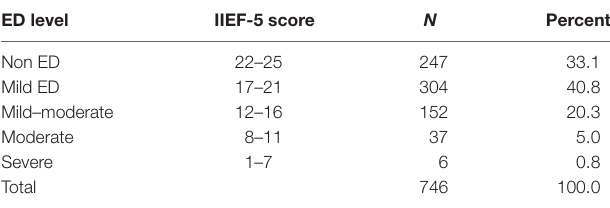
TaBle 2 | Distribution of erectile dysfunction (eD)